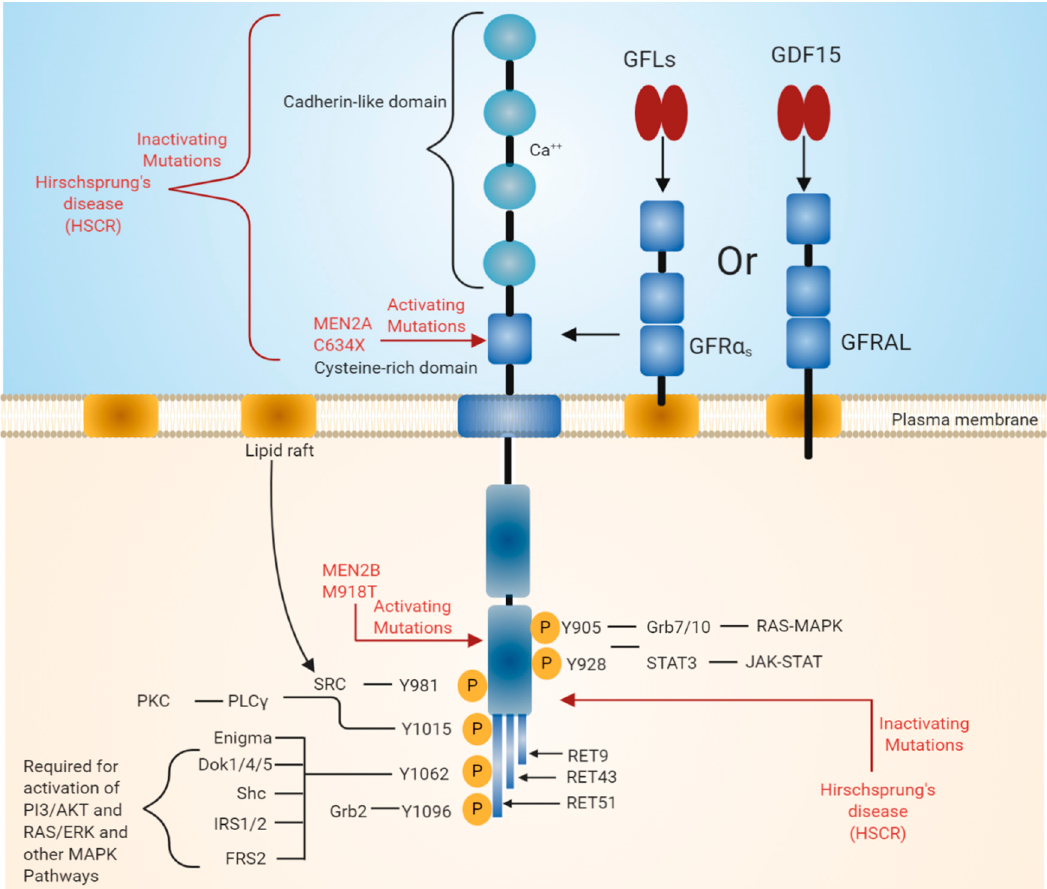
Figure 1. Rearranged in transfection (RET) receptor structure and its intracellular signaling pathway. The extracellular domain of RET contains four cadherin-like repeats and a cysteine-rich domain. Ca 2+ ions bind to the extracellular cadherin-like domains of RET, which is required for its activation. The intracellular domain of RET contains a typical kinase domain. RET has three isoforms (RET9, RET43, and RET51), which differ in their carboxy-terminal amino acids. RET9 and RET51 are evolutionarily highly conserved. RET is phosphorylated at multiple tyrosine residues when activated by different ligands. Phosphorylated tyrosine residues serve as docking sites for various adaptor proteins that induce the activation of downstream signaling pathways essential for cell growth, proliferation, survival, differentiation, or appetite control. The black line indicates the binding of adapter protein and the activation of downstream signaling pathways. The red line indicates mutations in the RET region that are responsible for diseases such as multiple endocrine neoplasia (MEN) syndromes 2A and 2B and Hirschsprung disease (HSCR).